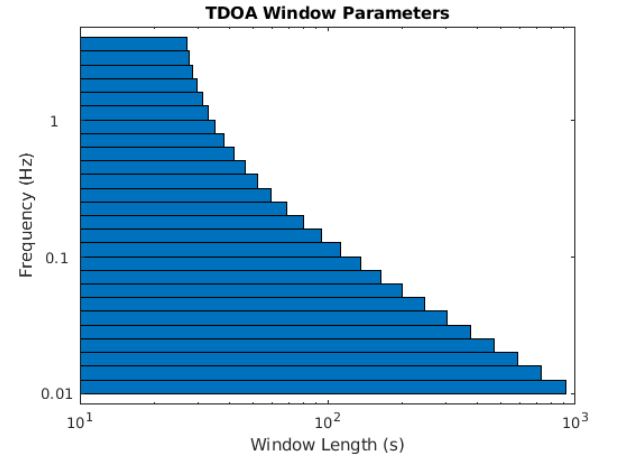
Figure 2. Example of TDOA outputs arrays for consistency, back azimuth, and trace velocity for a broadband white noise signal, which is filtered between 0.5 and 4 Hz, with a back azimuth of 30° and a trace velocity of 340.3 m/s.